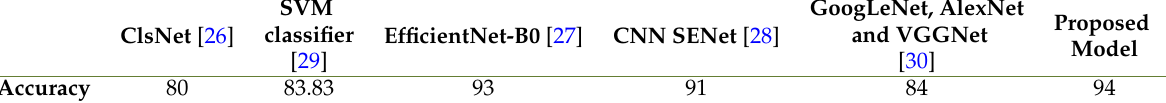
Table 4. SVM classification accuracy of the proposed approach in comparison with other approaches from the